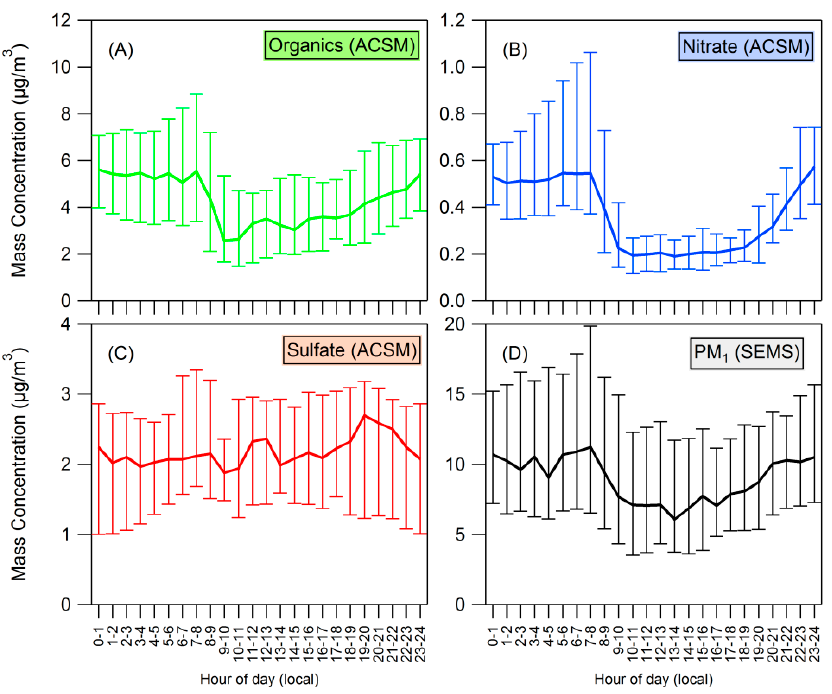
Figure 2. ( A – C ) Diurnal plots for organics, nitrate, and sulfate measured by the ACSM; ( D ) PM 1 measured by the SEMS. Median values are plotted, with error bars showing the 25 th and 75 th percentiles.